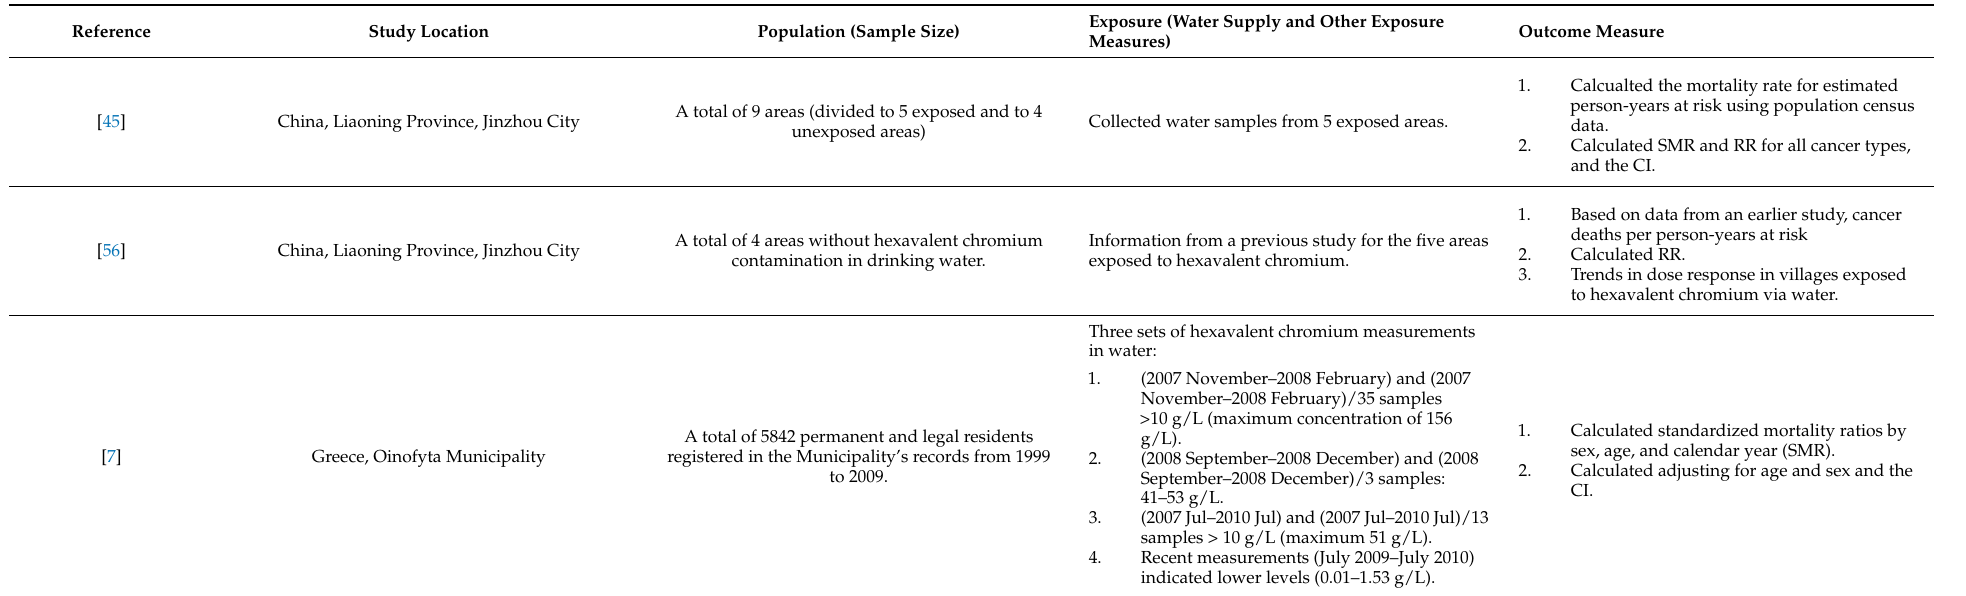
Table 6. Main characteristics of the selected ecological studies included in the systematic